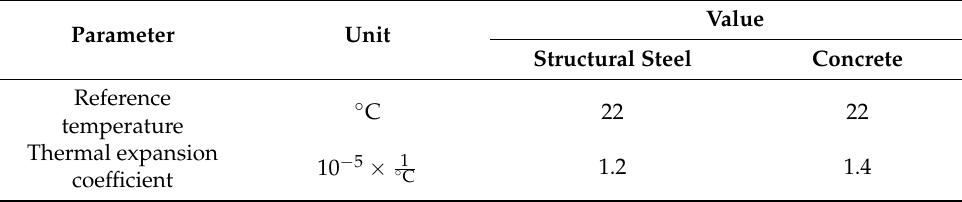
Table 2. Thermal properties of the primary materials used in this case study. Parameter